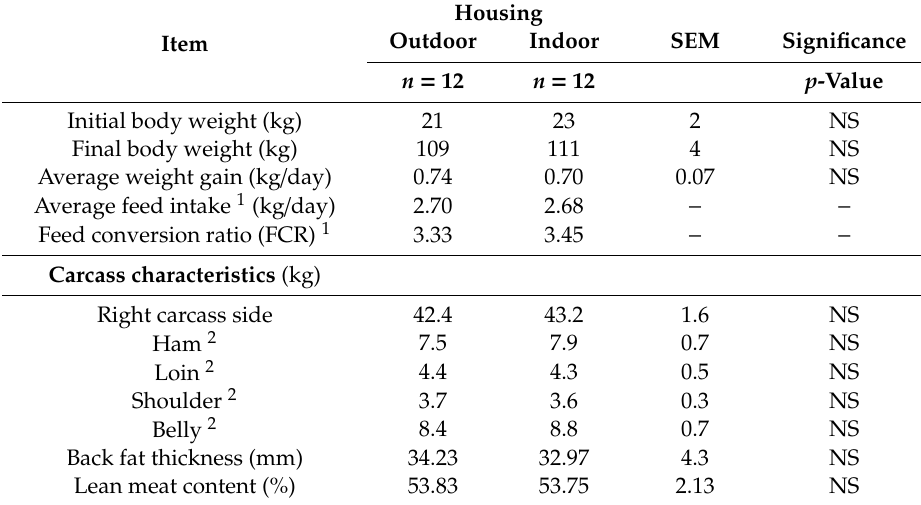
Table 4. Growth performance and carcass characteristics of Prestice Black-Pied pigs reared in di ff erent housing systems. Housing Outdoor Indoor SEM Significance Item n = 12 n = 12 p